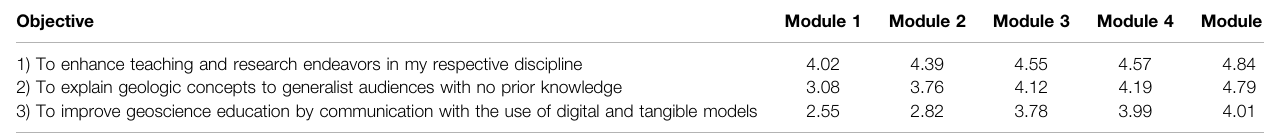
TABLE 2 | Comparison of student responses on ful fi lling the course learning objectives.